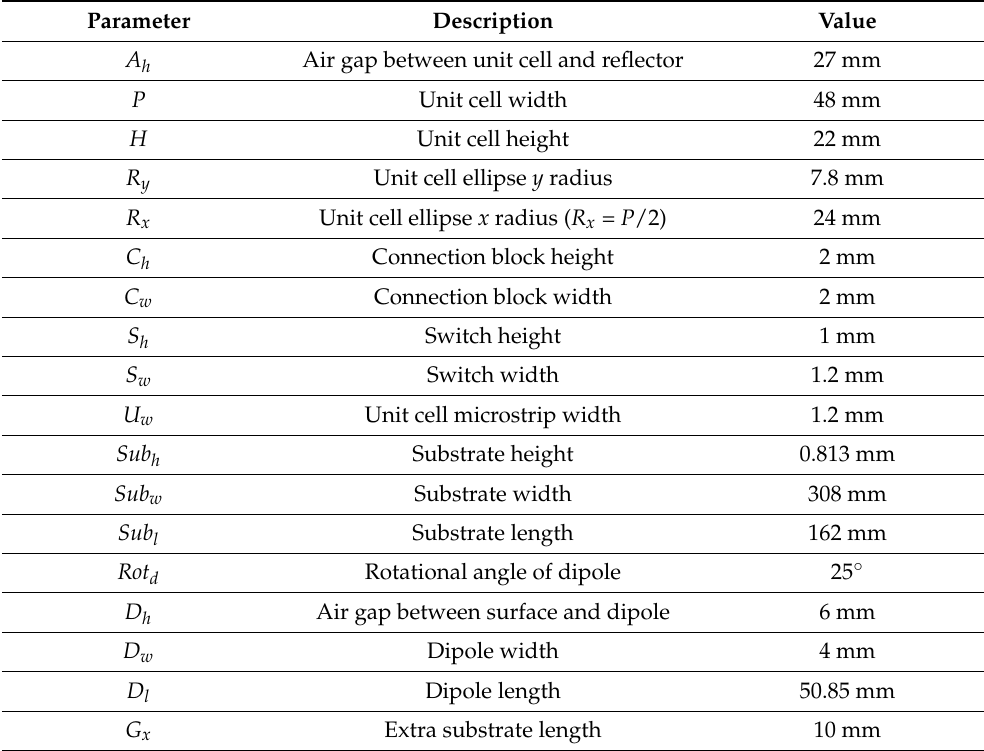
Table 1. Antenna parameter set